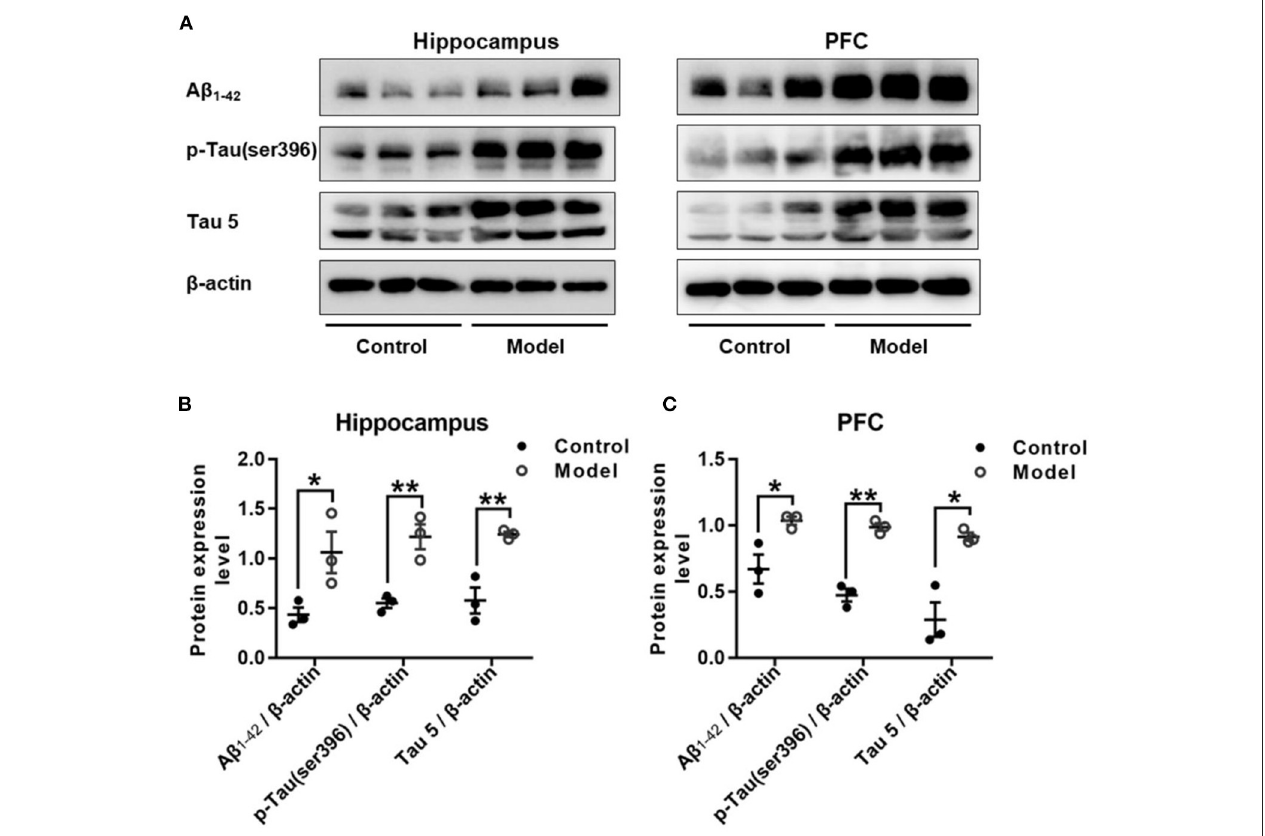
FIGURE 7 | Effect of bilaterally hippocampal injection of STZ on amyloid beta and Tau protein in the hippocampus and PFC of model mice. Typical graph (A) and statistical analyses (B,C) of the western blot results. Data in (B,C) are presented as the mean ± SEM ( n = 3 for each group). Compared with that in the control mice, the relative expression of A β 1 − 42 , p-Tau (ser396) and Tau 5 was increased in the hippocampus (A,B) and the PFC (A,C) of the model mice. * P < 0.05, ** P < 0.01; compared with the control